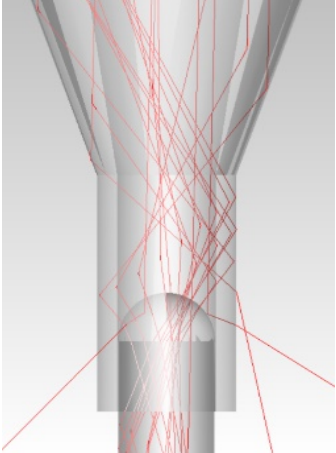
Figure 8. Ray tracing simulation with a small deflection angle.